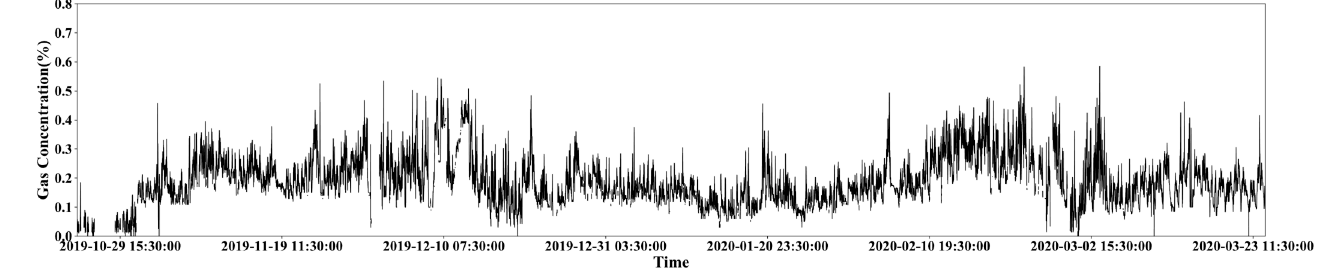
Figure A5. Variation trend of gas concentration in D6 data set.